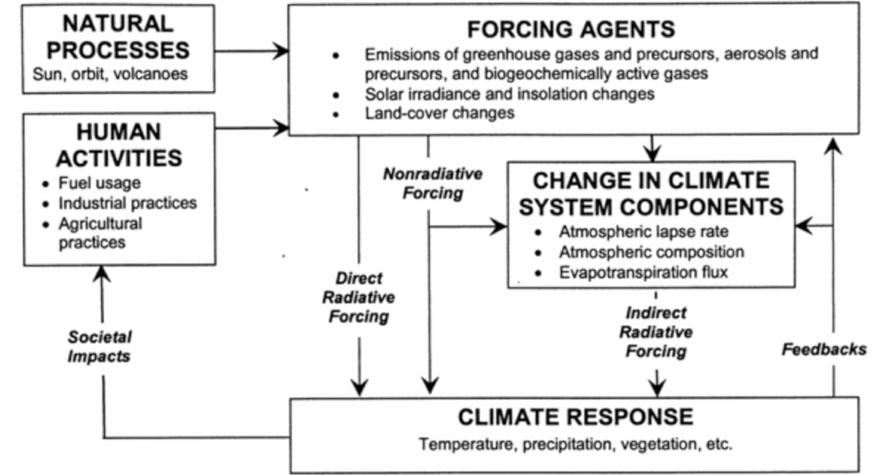
Figure 3. Conceptual framework of climate forcing, response, and feedbacks under present-day climate conditions. Examples of human activities, forcing agents, climate system components, and variables that can be involved in climate response are provided in the lists in each box from